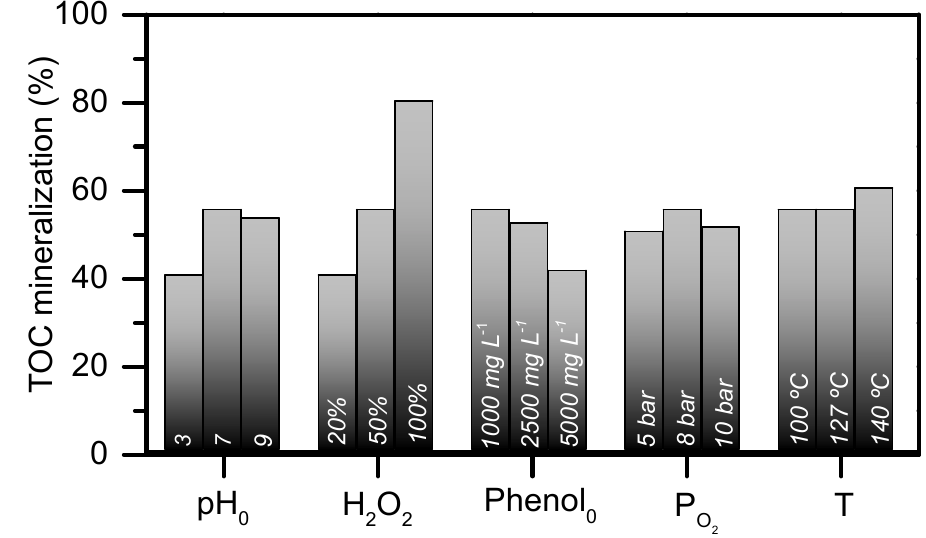
Figure 3. Effect of the operating conditions on the phenol mineralization after 3 h of reaction upon WPO-O 2 process. Standard conditions: [Phenol] 0 = 1000 mg L − 1 , [H 2 O 2 ] 0 = 2500 mg L − 1 , P O 2 = 8 bar, T = 127 °C and natural pH 0 .